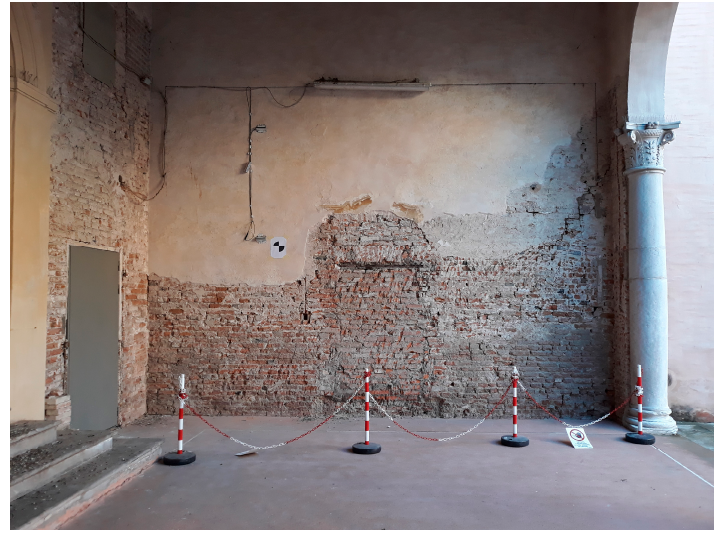
Figure 3. External view of the studied wall (internal courtyard under the porch) [6].